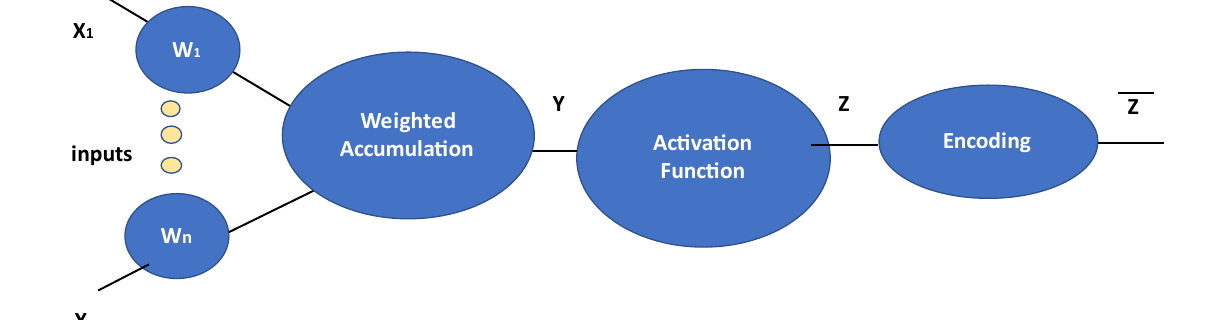
Figure 12. Interpretation of computation of a neuron to sequence of operations in RAPIDNN network [8].